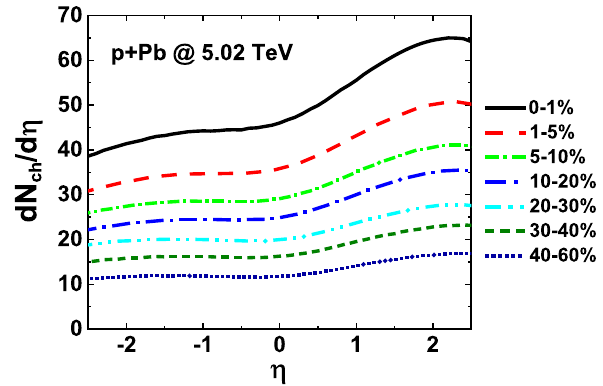
Fig. 1 The pseudorapidity dependence of charged hadron multiplicity dN / d η for various centrality bins in 5.02 TeV p + Pb collisions